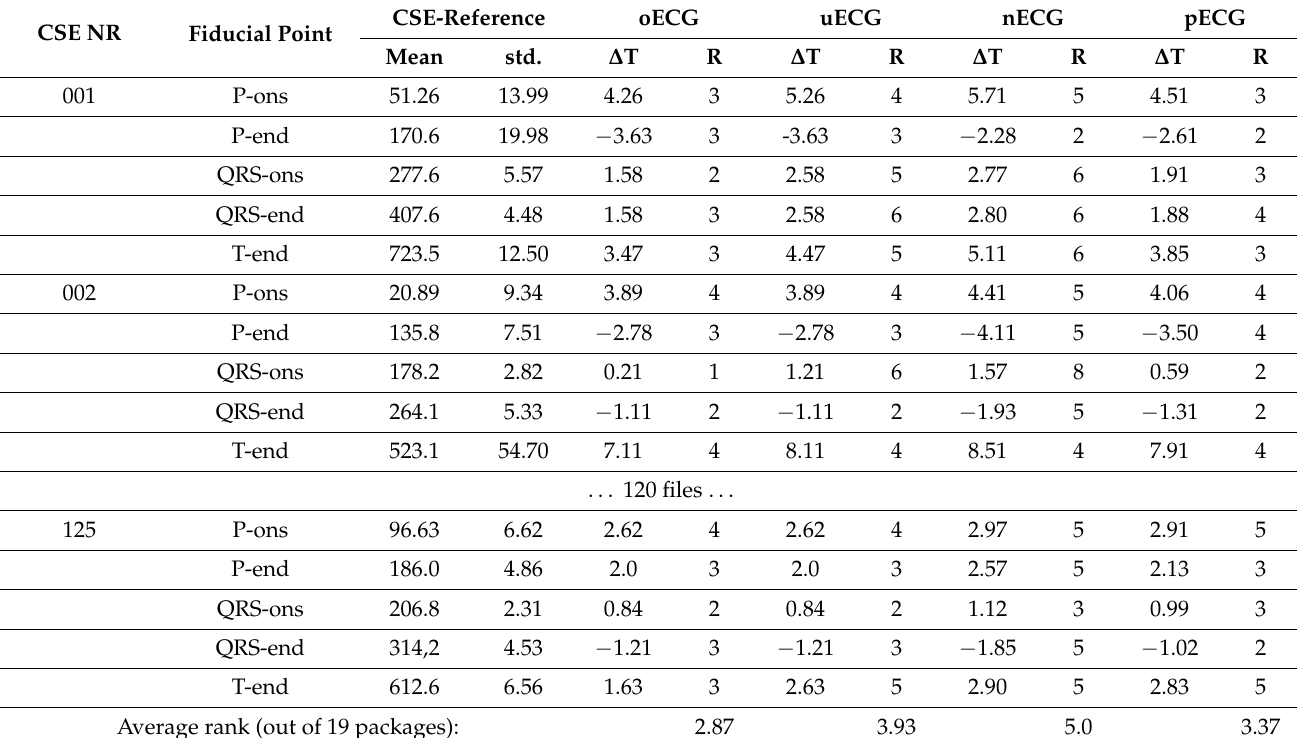
Table 6. Excerpt from the detailed analysis of wave delineation result with CSE database (files 67 and 70 are excluded). CSE NR Fiducial Point